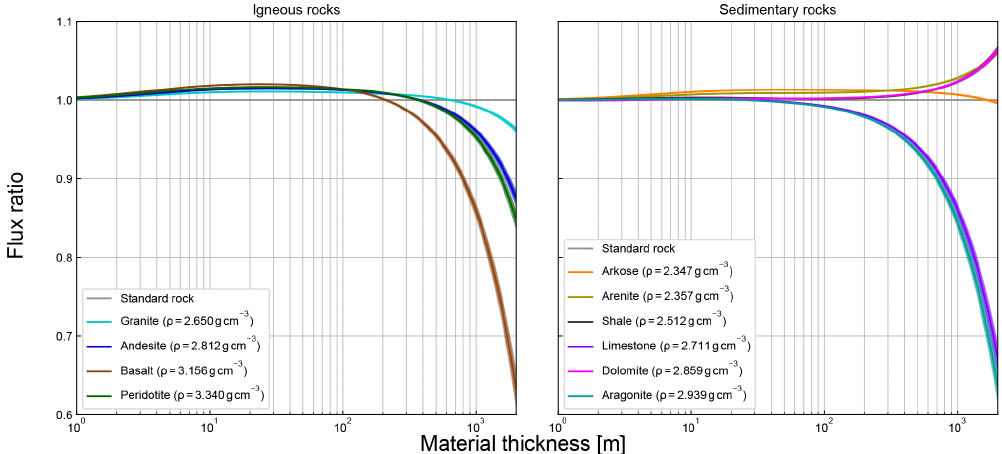
Figure 7. Ratio of the simulated rock fluxes to a standard rock muon flux with the same density as the rock ( ρ SR = ρ Rock ) for all the lithologies in Table 1 as a function of rock